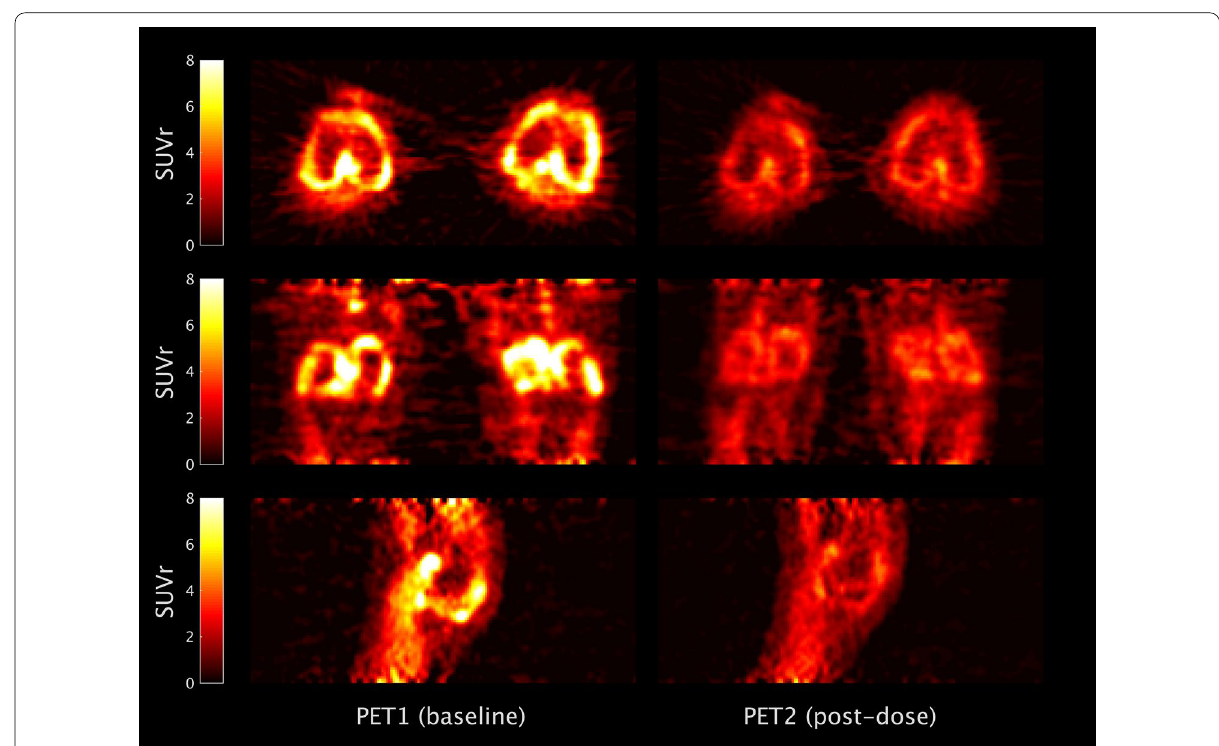
Fig. 4 Trans-axial (top), coronal (middle) and sagittal (bottom) images of [ 11 C]PBR28 uptake normalized for blood activity (SUVr 50–70 blood) in subject 2 shows synovial uptake at baseline (PET1 baseline) that is reduced after administration of oral emapunil (PET2